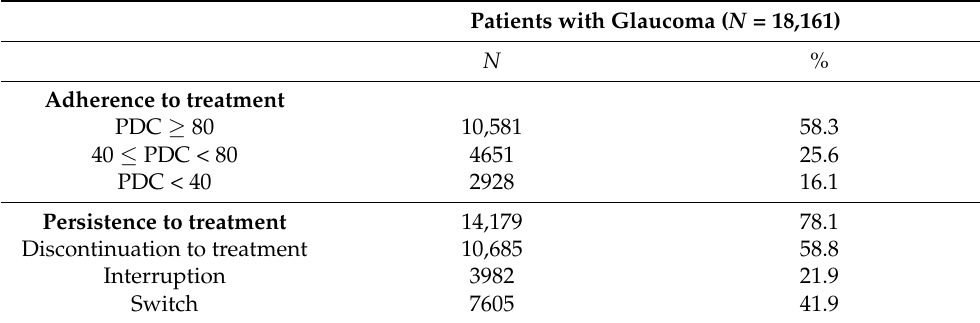
Table 3. Drug utilization over first year of follow-up in patients with